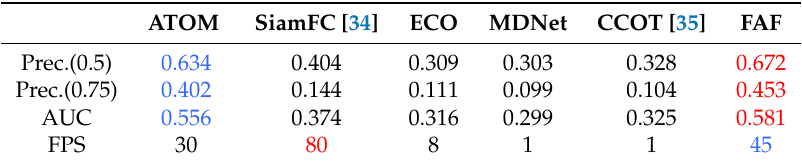
Table 4. Comparison with the state-of-the-art trackers on the GOT10K dataset. The results are presented in terms of precision (0.5), precision (0.75), and robustness value (R). The best and second results are in red and blue, respectively.